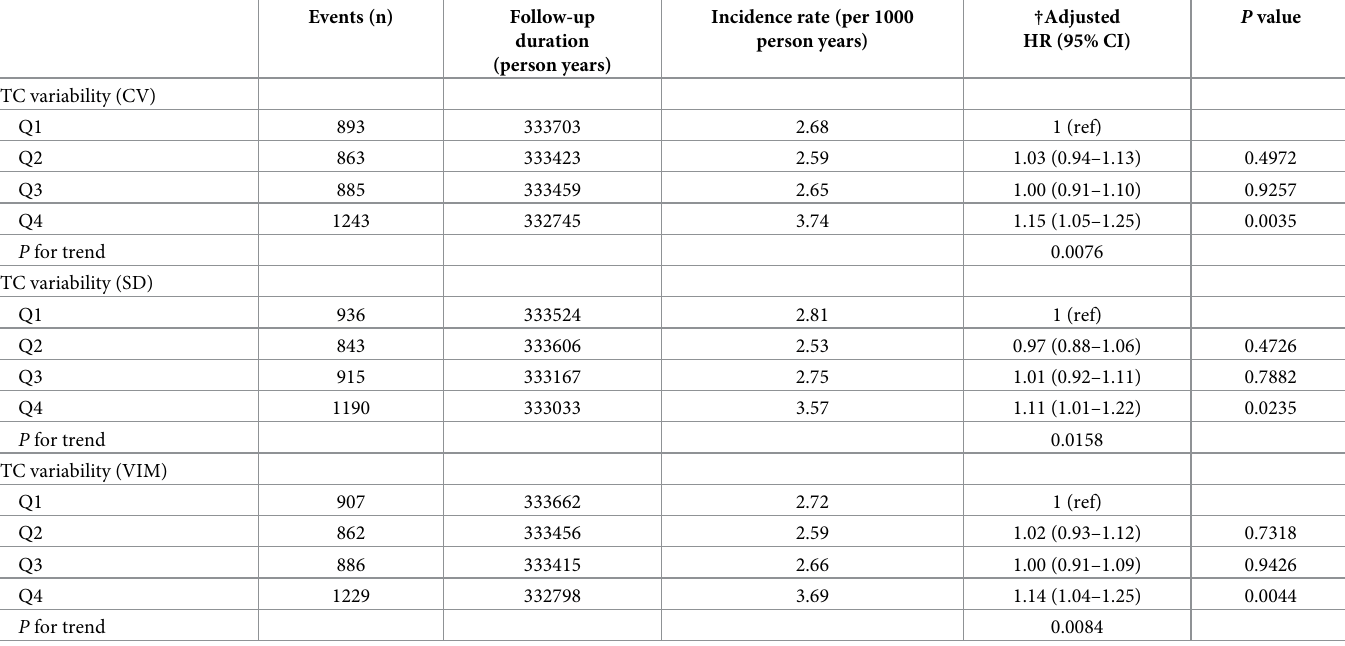
Table 2. Hazard ratios and 95% confidence intervals of atrial fibrillation by quartiles of total cholesterol